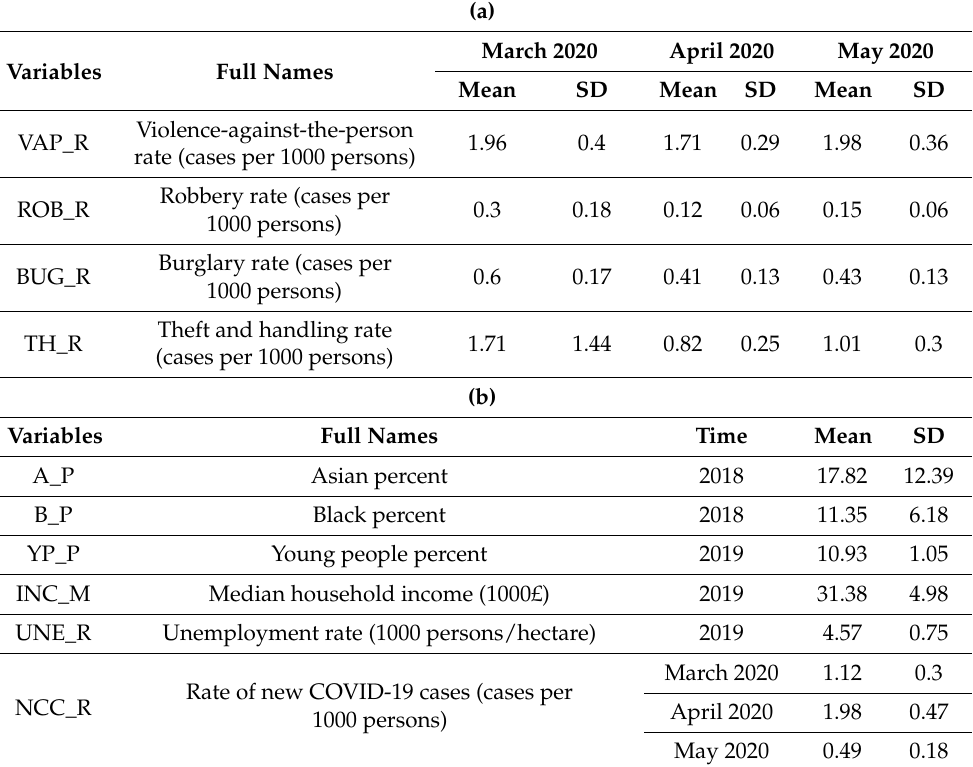
Table 2. Introduction and descriptive statistics of variables considered in this study. ( a ) Response variables; ( b ) Explanatory